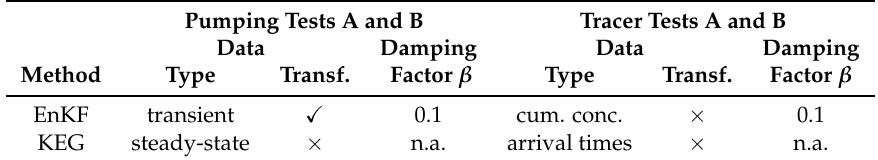
Table 2. Settings of the Ensemble Kalman Filter (EnKF) and Kalman Ensemble Generator (KEG) used for the assimilation of hydraulic-head and tracer data. “ (cid:88) ” and “ × ” indicate whether normal-score transformations were applied or not. Transf: transformation; cum. conc.: cumulative concentration time series. Pumping Tests A and B Tracer Tests A and B Data Damping Data Damping Method Type Transf. Factor β Type Transf. Factor β EnKF transient (cid:88) 0.1 cum. conc. × 0.1 KEG steady-state × n.a. arrival times ×